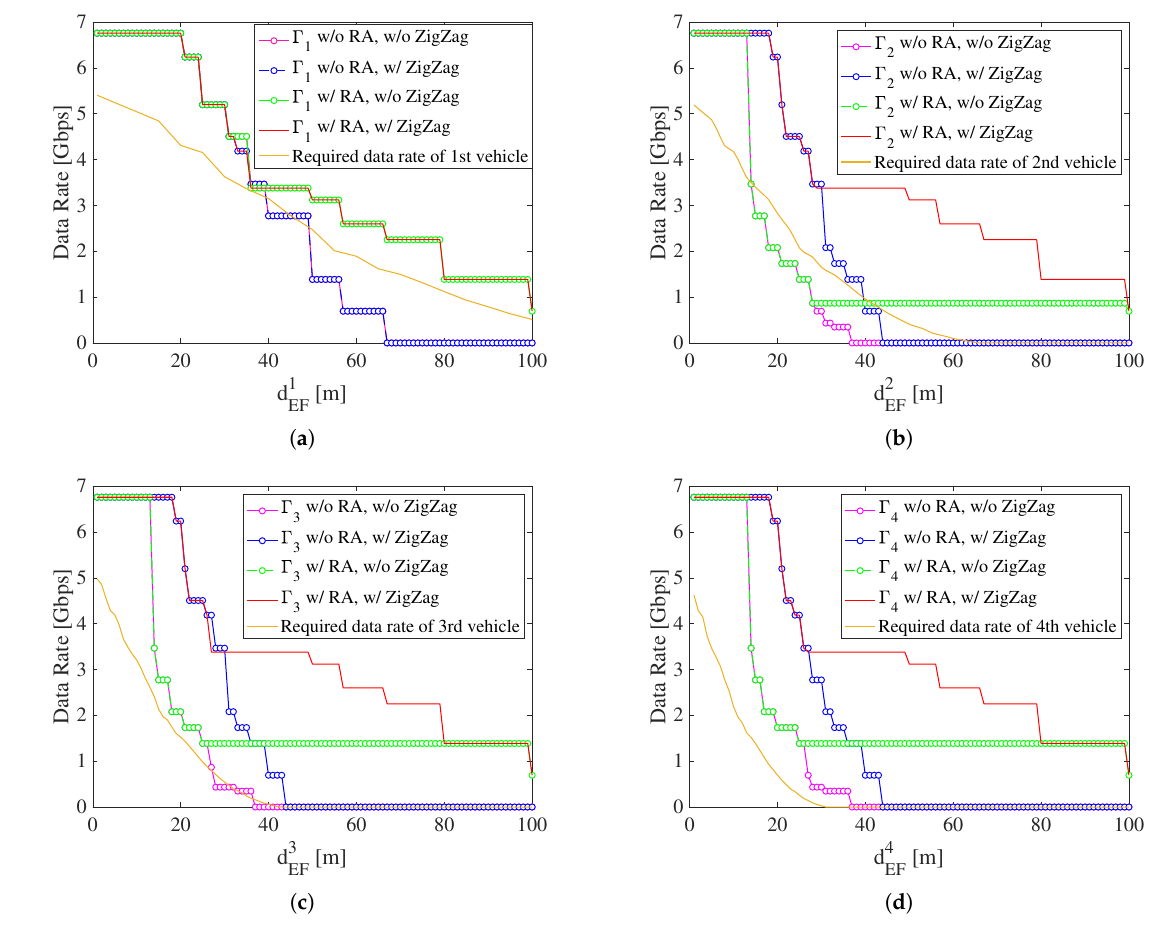
Figure 8. Comparison between achievable E2E throughput and required data rate with equal inter-vehicle distance ( G t = G r = 30 dBi, p Mode1 = − 11 dBm, p Mode2 = 4 dBm, d switch = 36 m ( n = 1 ) or 30 m ( n > 1 ) , B = 2.16 GHz, d n ∈ ( 0,100 ] ). ( a ) First vehicle; ( b ) second vehicle; ( c ) third EF vehicle; ( d ) fourth